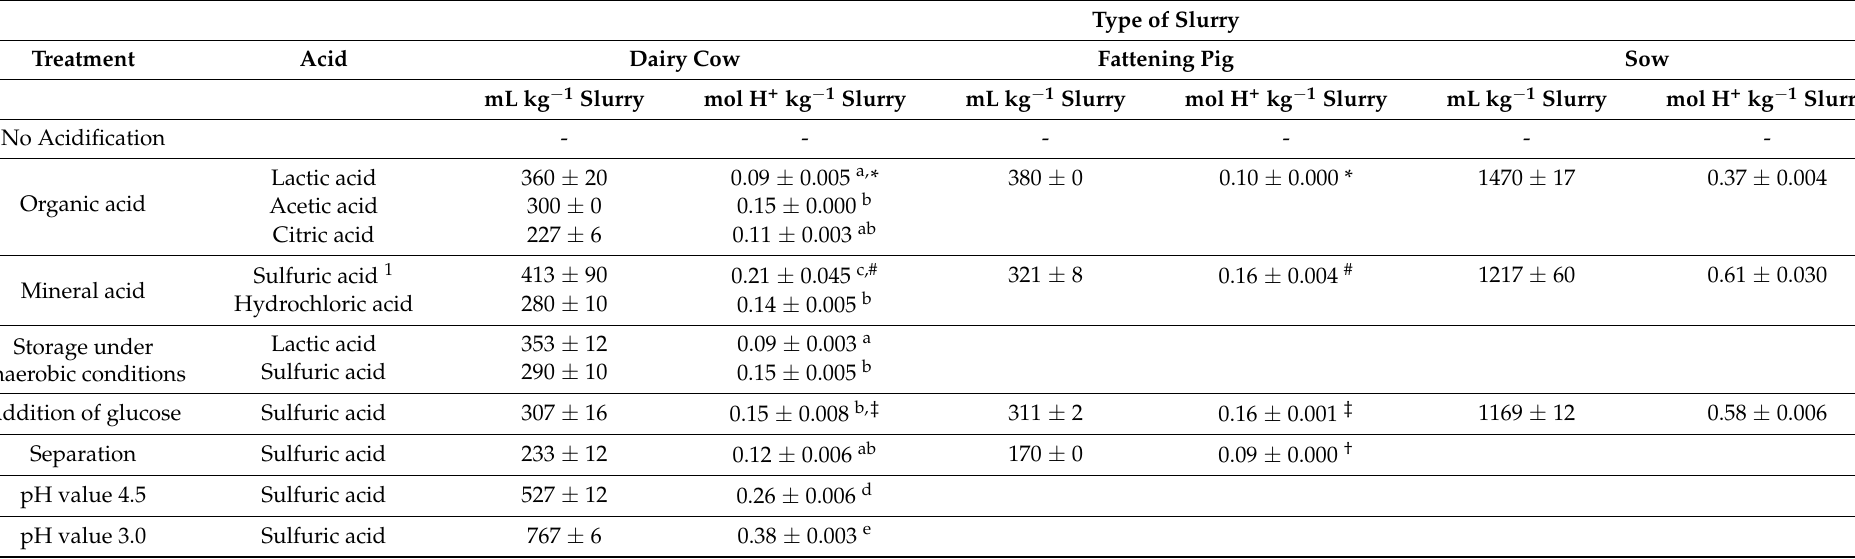
Table 3. Amount of acid required to decrease the pH to 5.5 if not indicated otherwise (means ± SD, n =